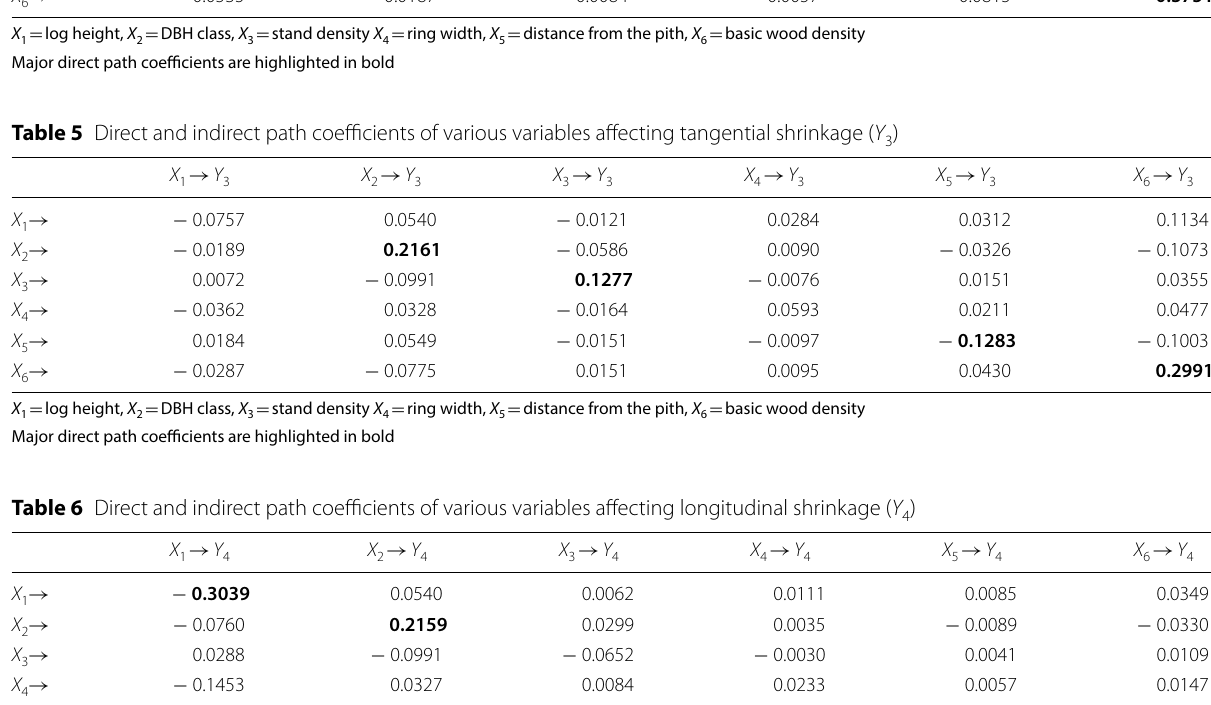
Major direct path coefficients are highlighted in